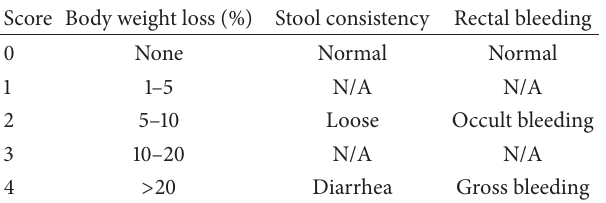
Table 1: Disease activity index (DAI) scoring criteria.